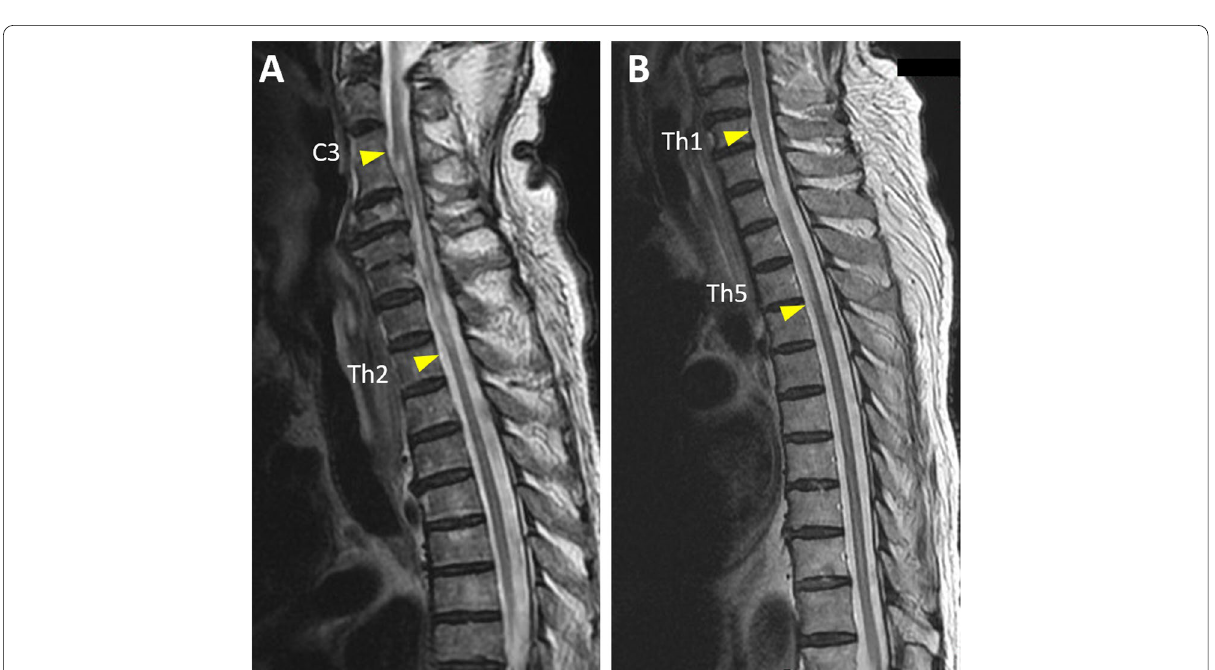
Fig. 2 Magnetic resonance images from the 2 patients with postoperative paraplegia (SCI patient 1 and SCI patient 2 in a and b , respectively). SCI patient 1: 81-year-old man. SCI patient 2: 82-year-old